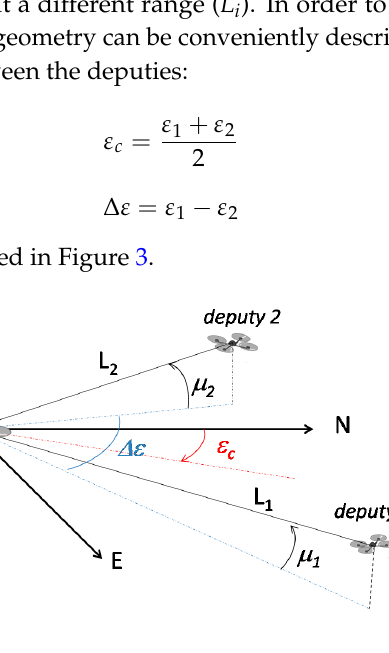
Figure 3. Formation geometry parameters.